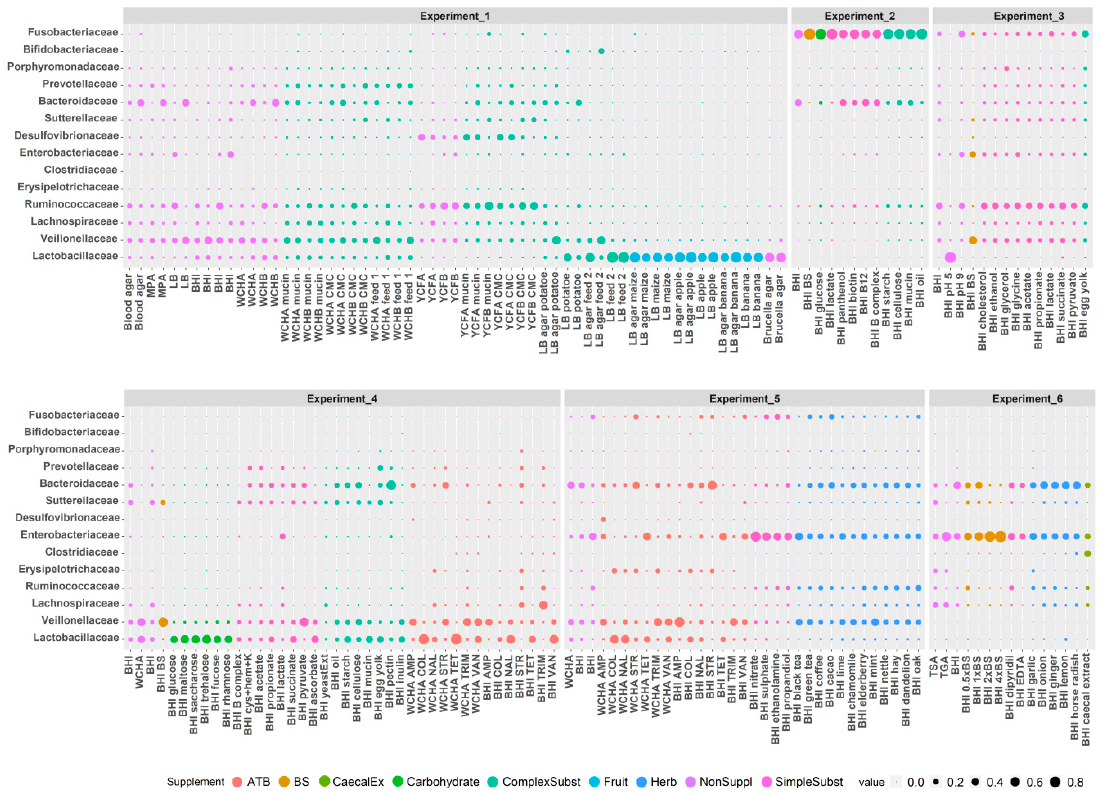
Figure 4. Growth of major families in particular nutrient media in vitro. Individual experiments are separated by a gap. Sizes of the dots indicate the abundance of a given family in a particular growth medium. See Figure S3 to zoom